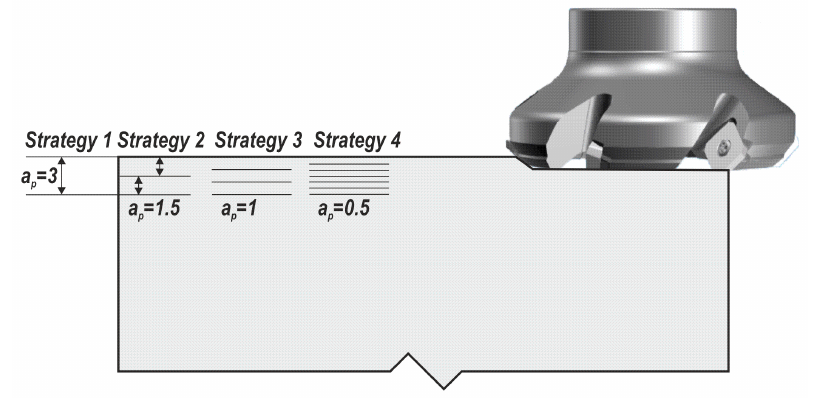
Figure 2. Cutting Figure 2. Cutting strategies.